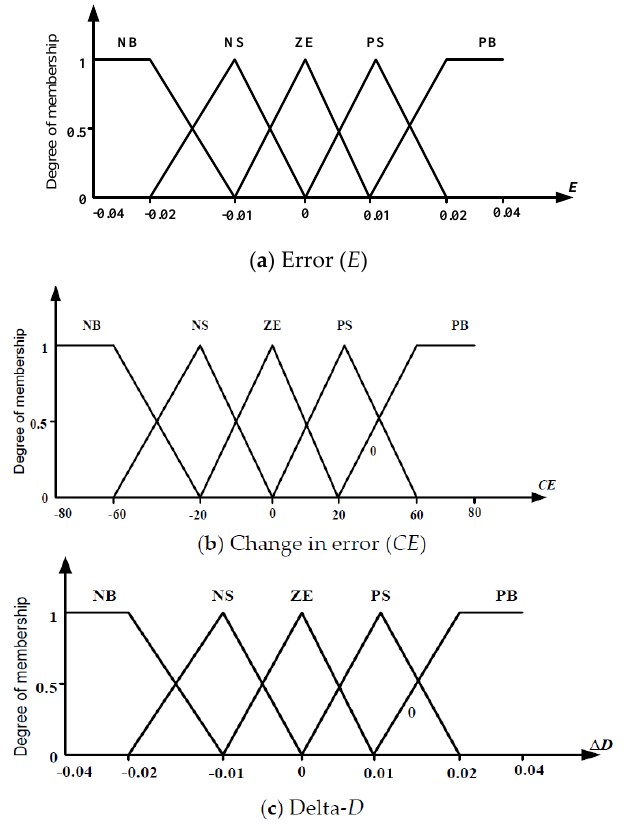
Figure 4. Membership function for inputs and outputs.